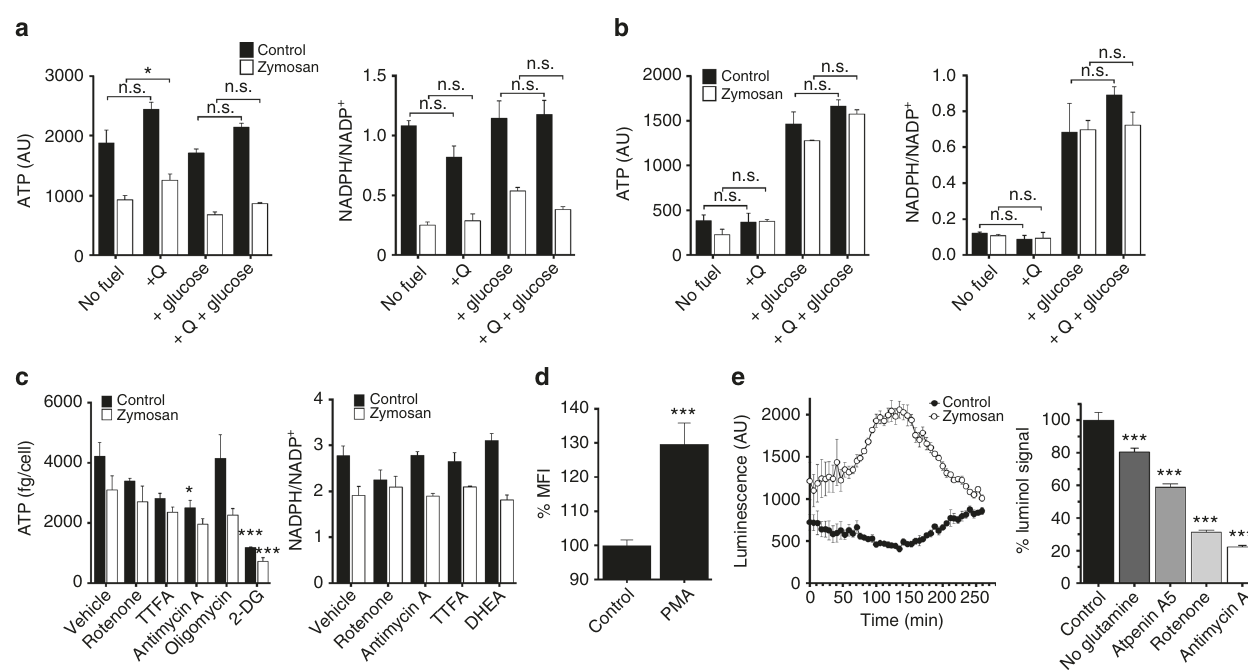
Fig. 8 The electron transport chain is required for nominal reactive oxygen species production in peritoneal tissue-resident macrophages. a Bar graphs showing ATP and NADPH assays of peritoneal tissue-resident macrophages (pTRMØ). Cells were starved of glutamine (2 mM) and/or glucose (25 mM) 1 h before addition of zymosan (50 μ g/ml) or control, extracts were taken after 2 h. Data were analysed by two-way ANOVA. For ATP, interaction p = 0.16, effects of zymosan or fuel p < 0.0001. For NADPH ratio, interaction p = 0.041. b Bar graphs showing ATP and NADPH assays of neutrophils. Cells were treated as in a , data were analysed by two-way ANOVA with Sidak ’ s post-tests for glutamine addition. For ATP, interaction p = 0.21, zymosan p = 0.15, fuel p < 0.0001. For NADPH ratio, interaction p = 0.85, zymosan p = 0.56, fuel p < 0.0001. c Bar graphs showing ATP and NADPH assays of pTRMØ. Cells were treated with inhibitors 30 min before addition of zymosan as in a . Oligomycin (1.26 μ M), rotenone (200 nM), thenoyltri fl uoroacetone (TTFA, 2 mM), antimycin A (1 μ M), dehydroepiandrosterone (DHEA, 100 μ M), 2-deoxyglucose (2-DG, 100 mM). Data were analysed by two-way ANOVA with Sidak ’ s post-tests vs control. For ATP, interaction p = 0.47, zymosan or drug were p < 0.0001. For NADPH ratio, interaction p = 0.036. Data a – c represent at least two independent experiments and show 3 – 4 separate wells per group. d Bar chart showing the median fl uorescent intensity (MFI) of mitoSOX dye in Ncf1 − / − pTRMØ treated with phorbol – myristate – acetate (PMA, 1 μ M) or control. Data ( n = 4 separate wells per group) represent two independent experiments and were analysed by Student ’ s t -test. e Line graph (left) showing luminol luminescence against time in pTRMØ treated with zymosan 1 min before time 0. Bar chart (right) showing quanti fi cation of the area under the curve luminescence from the line graph in the presence of the